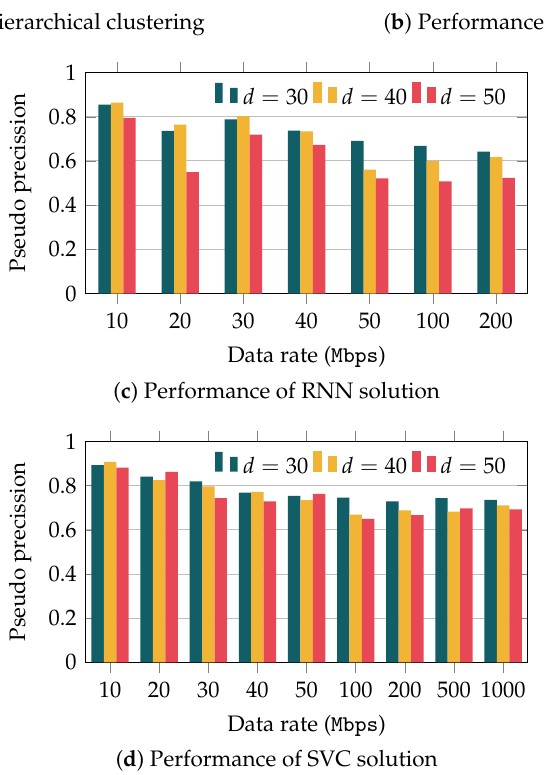
Figure 11. Comparison of the different algorithm for multi-level